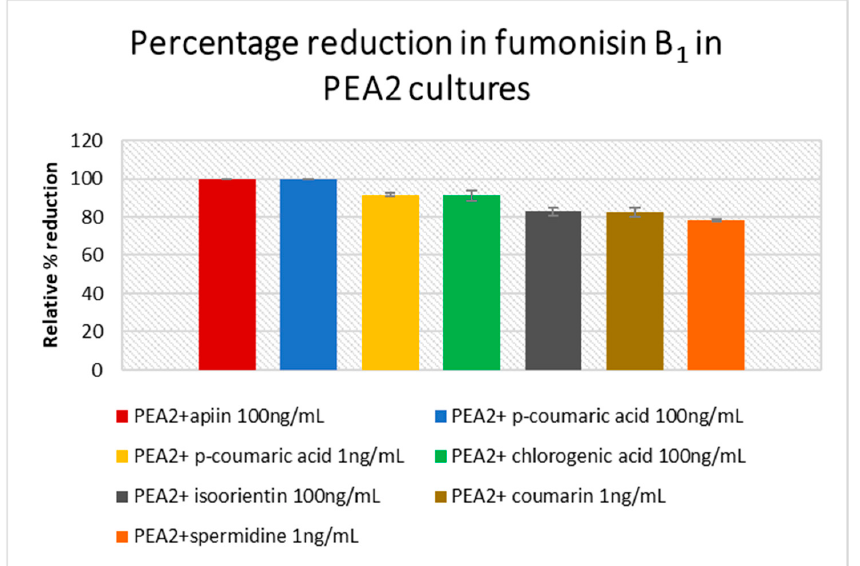
Figure 5. Percentage of fumonisin B 1 reduction with respect to the control in F. proliferatum PEA2 cultures treated with various concentrations of host metabolites. Error bars represent standard error.